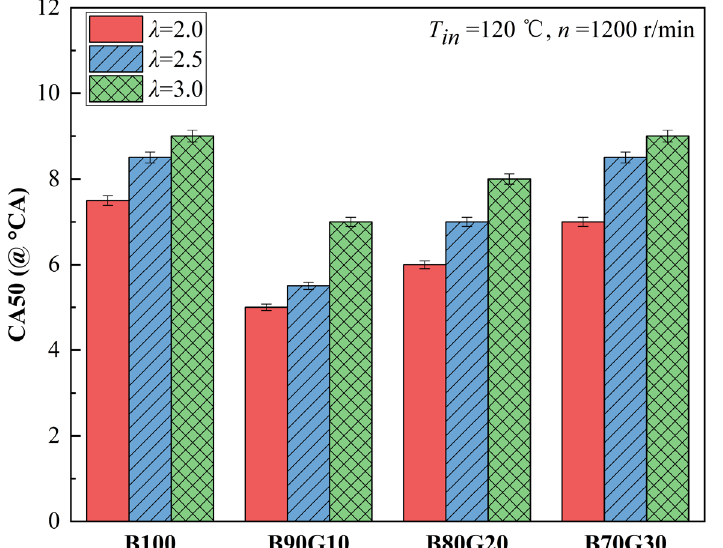
Figure 5. CA50 with different λ s.